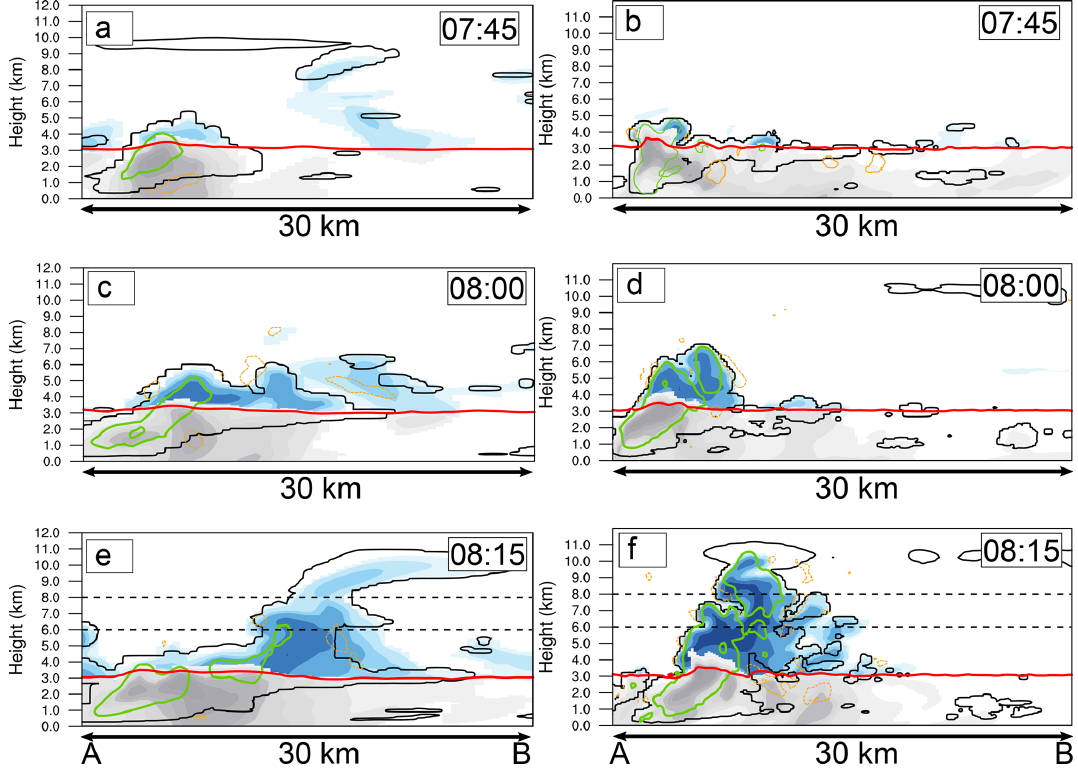
Figure 11. Vertical cross section along a convective cell for (a) LR450 and (b) HR150 at 07:45, 08:00 and 08:15UTC. Rainwater contents (gkg − 1 ) are represented in grey, whereas mixed precipitating hydrometeor (graupel and snow aggregate) contents (gkg − 1 ) are highlighted in blue. The black solid line delineates the cloud boundaries (threshold of cloud and ice water contents > 0 . 001gkg − 1 ). Updraughts (green lines) and downdraughts (orange dashed lines) are represented with a threshold of about 5ms − 1 and − 2ms − 1 , respectively. The red solid line stands for the freezing